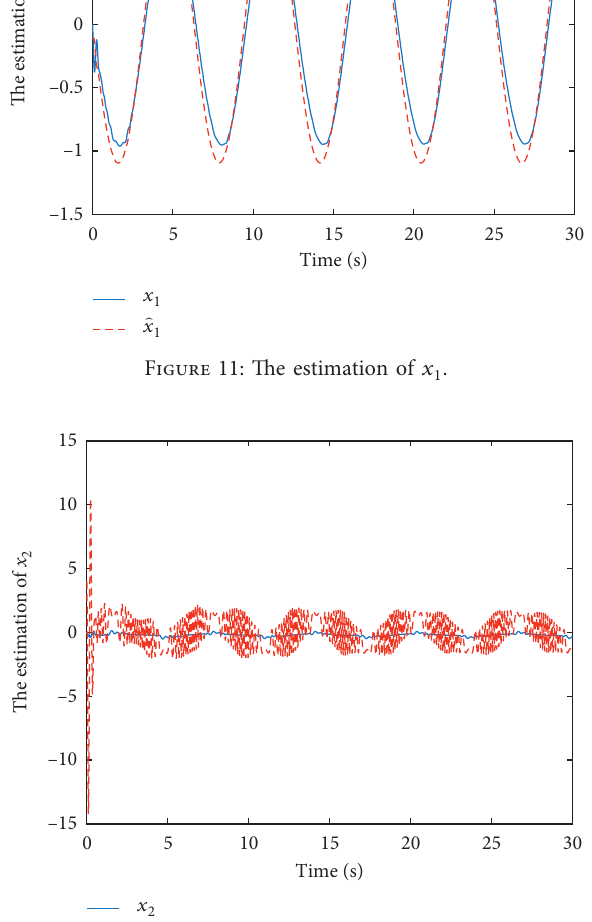
Figure 12: The estimation of x